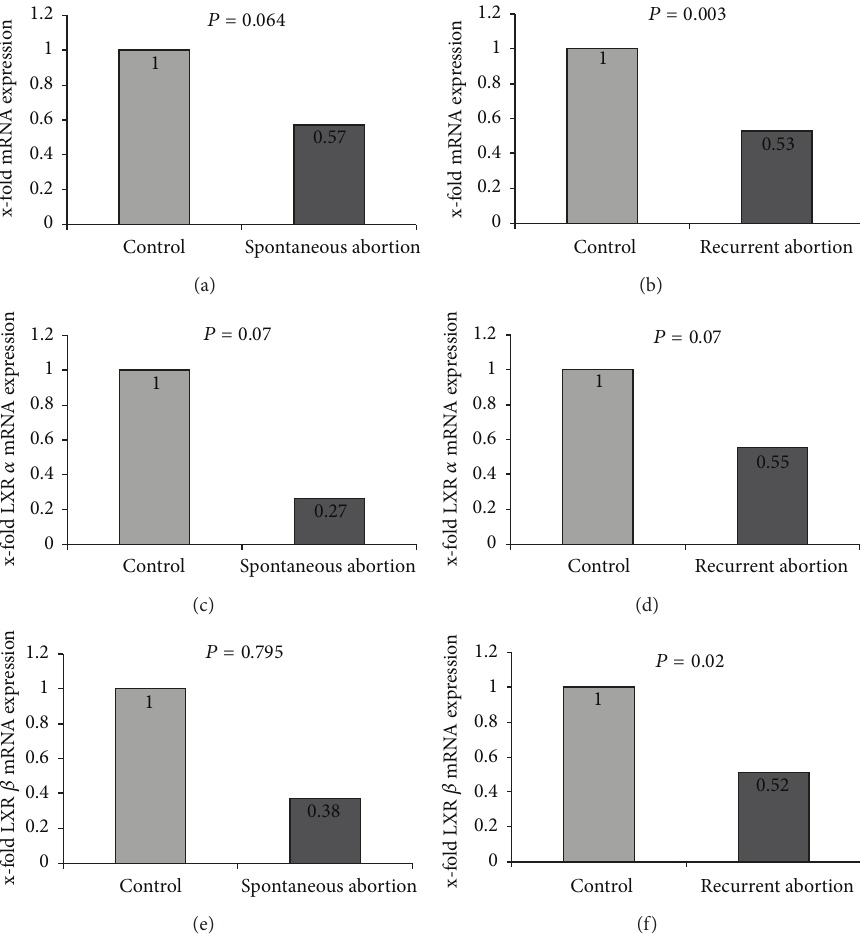
Figure 2: Quantification of mRNA expression of LXR A and B in placentas of spontaneous miscarriages and recurrent miscarriage. (a) We identified a nonsignificant downregulation of LXR mRNA expression in spontaneous abortion placentas compared to normal controls (57%, 𝑃 = 0.064 ). (b) In recurrent abortion we identified a downregulation of LXR mRNA expression to 53% compared to control placentas. (c) LXR A was downregulated to 27% ( 𝑃 = 0.07 ) and (e) LXR B was downregulated to 38% ( 𝑃 = 0.795 ). (d) LXR A was downregulated to 55% ( 𝑃 = 0.07 ) and (f) LXR B was downregulated to 52% ( 𝑃 = 0.02 ). Mann-Whitney- 𝑈 test was used for evaluation of two independent